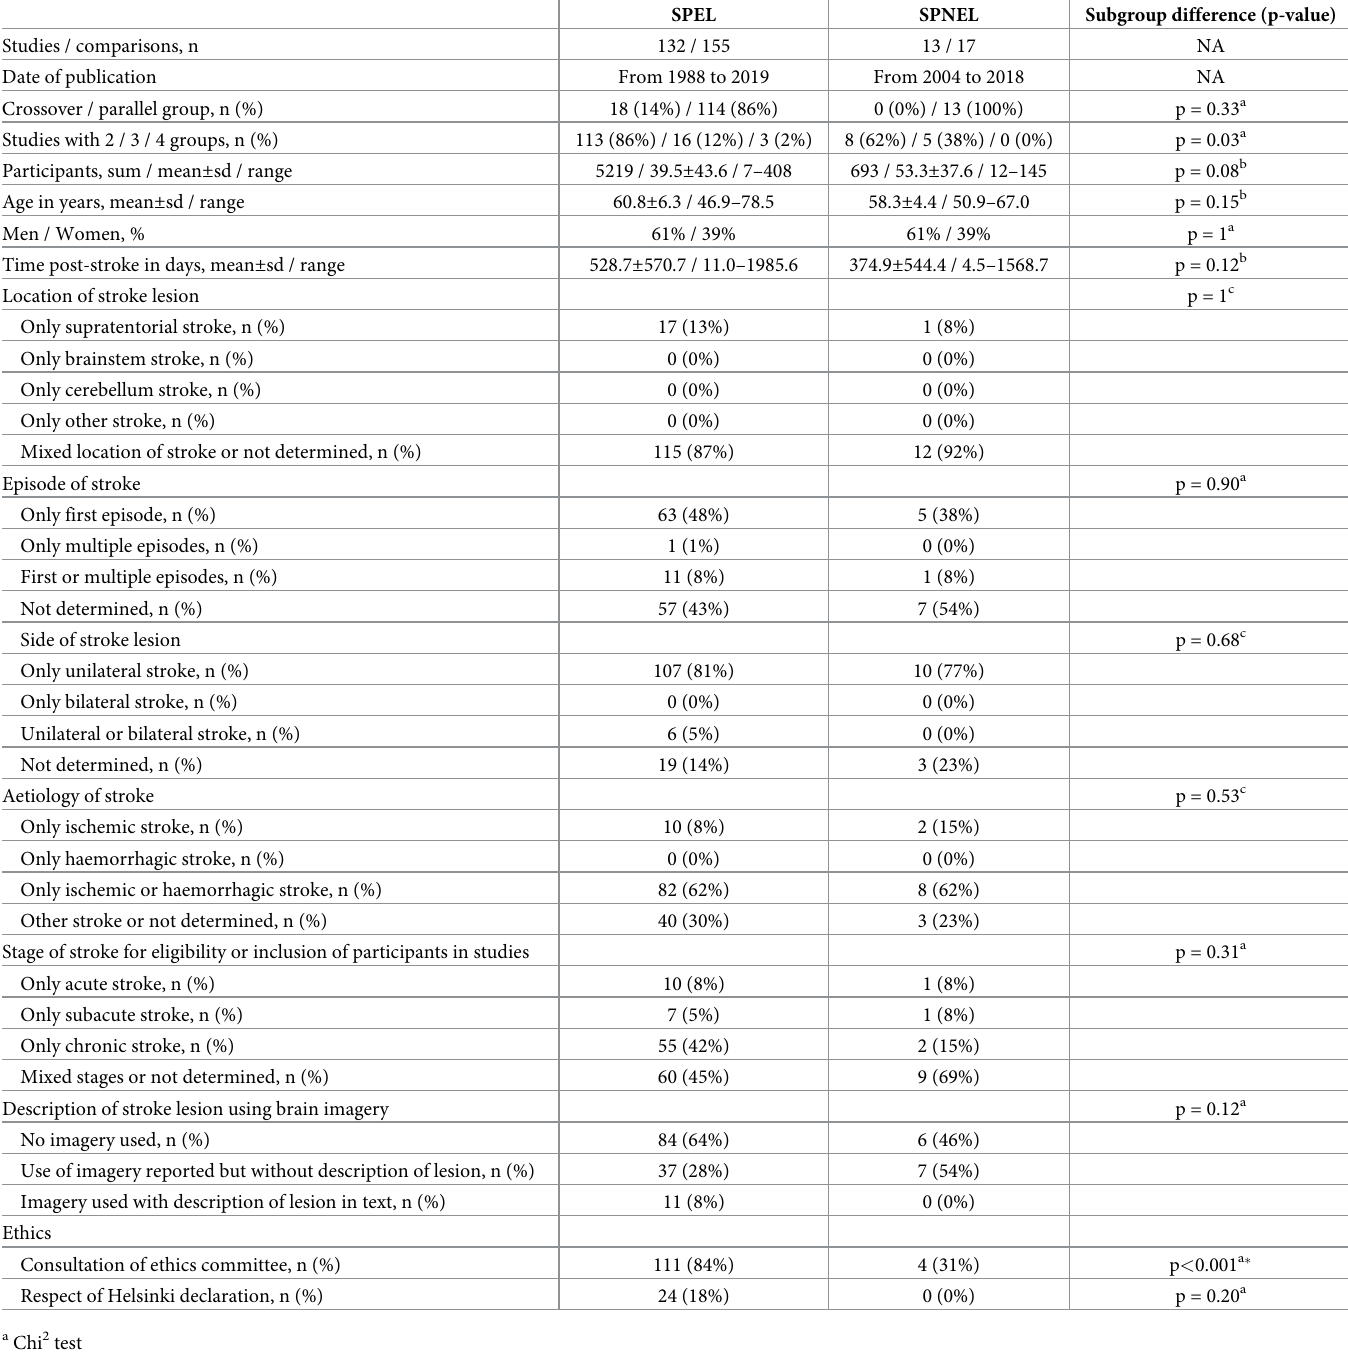
Table 1. Summary of characteristics of studies and